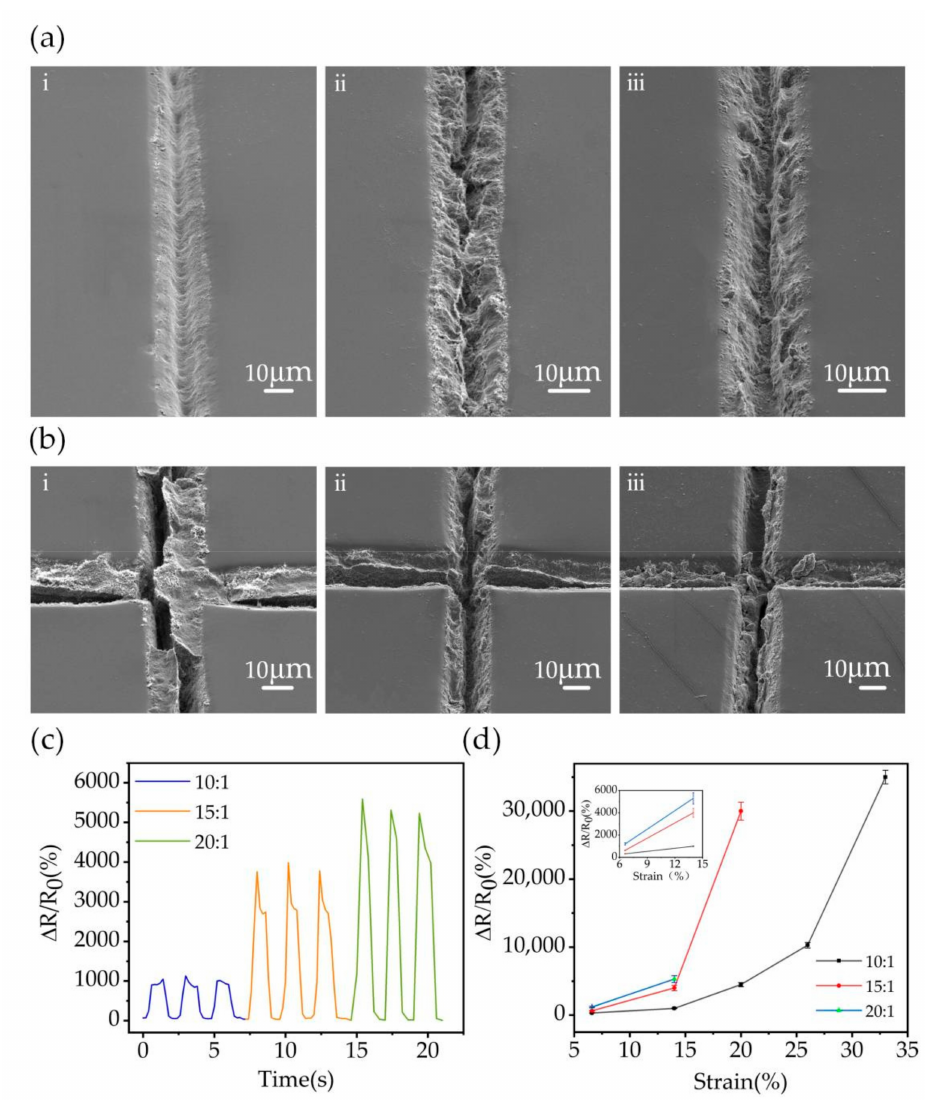
Figure 2. Performance of sensors prepared with different ratios of PDMS prepolymer and cross- linker. ( a ) MWCNT filling effect of PDMS films prepared with different ratios: 10:1, 15:1, and 20:1. ( b ) Stretching effect after filling MWCNT with PDMS films of different proportions. ( c ) Variation of ∆ R/R 0 at 14% tensile strain for sensors prepared with different PDMS ratios. ( d ) Maximum